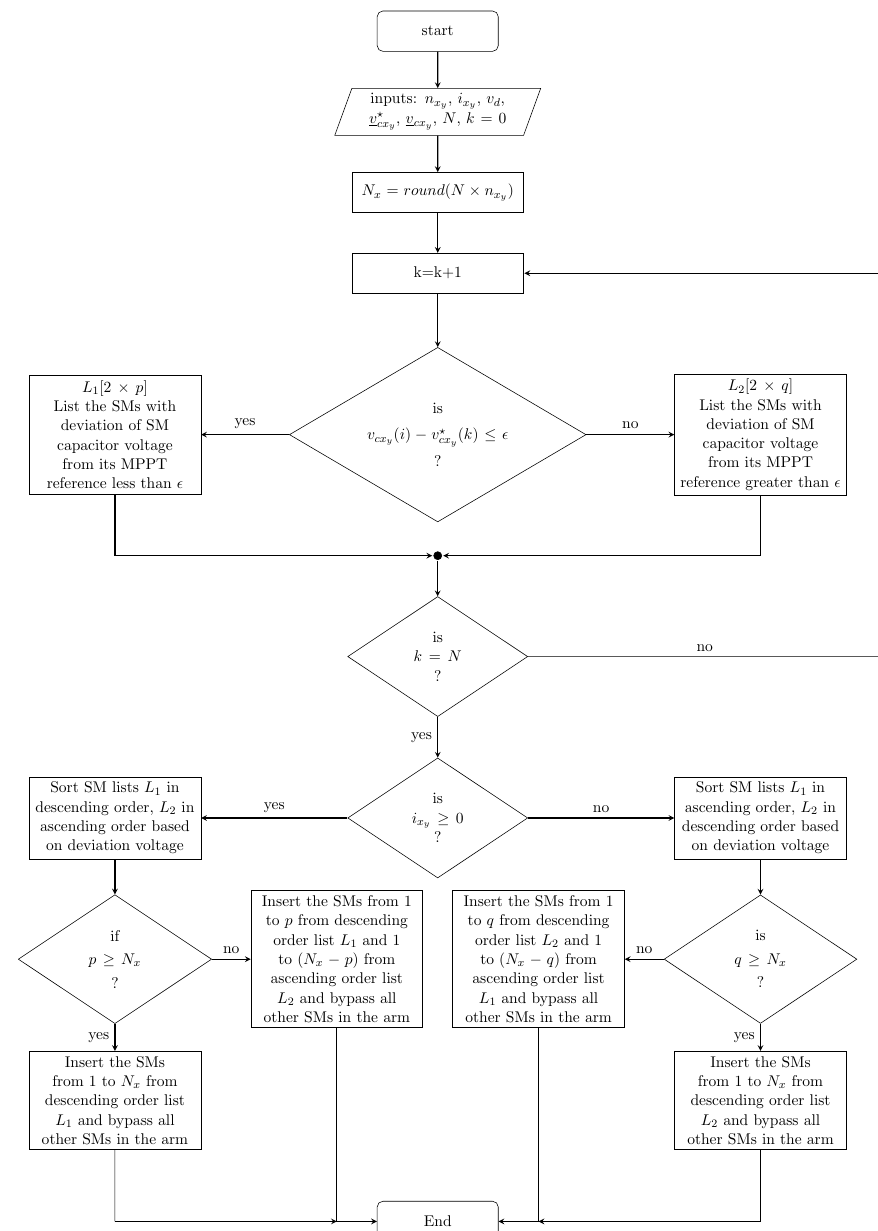
Figure 5. The sorting and tracking algorithm used in the arm power control of the MMC for PV application [13].